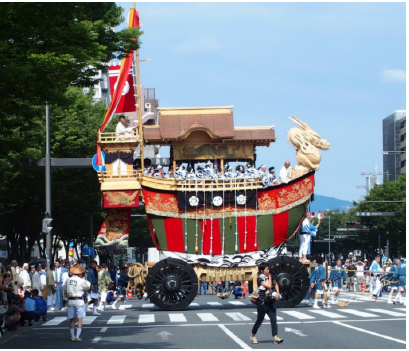
Figure 1. The Ofune-hoko float in the Gion Festival (2014).